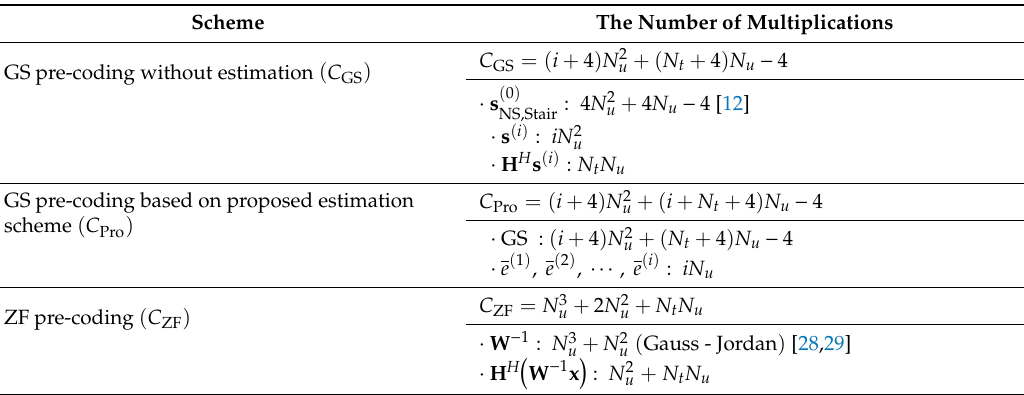
Table 1. The number of required multiplications for conventional GS pre-coding, GS pre-coding based on the proposed estimation scheme, and ZF pre-coding.